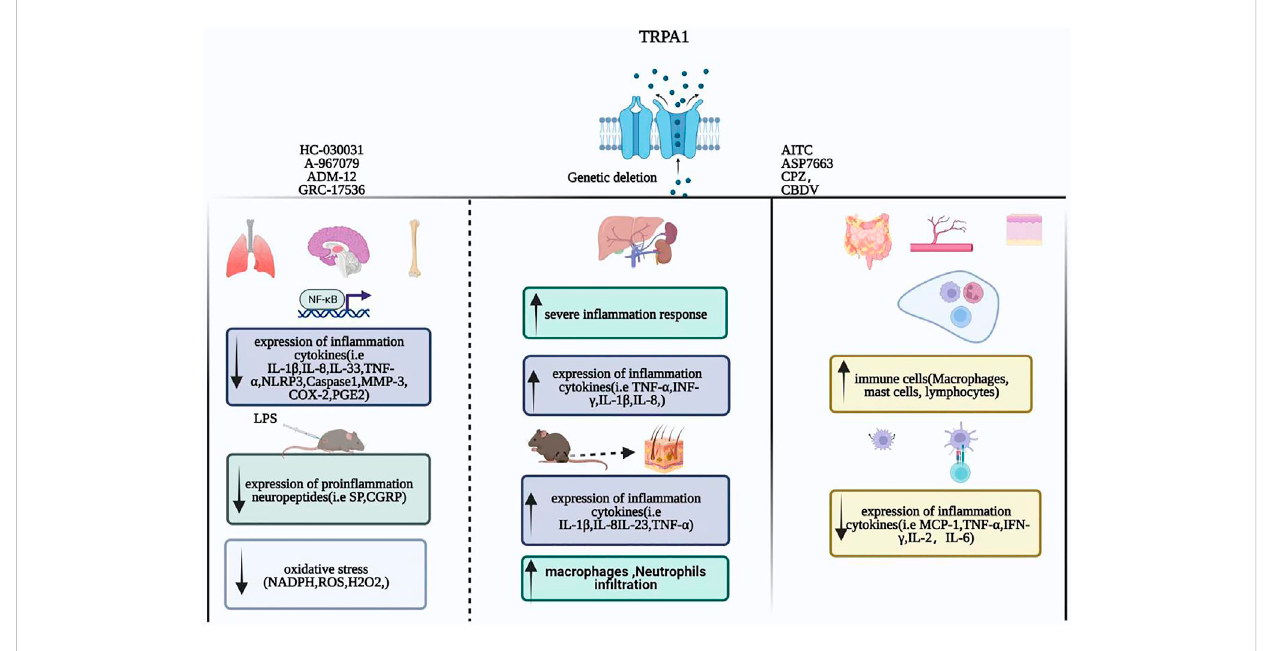
FIGURE 1 In fl ammation: The role of the TRPA1